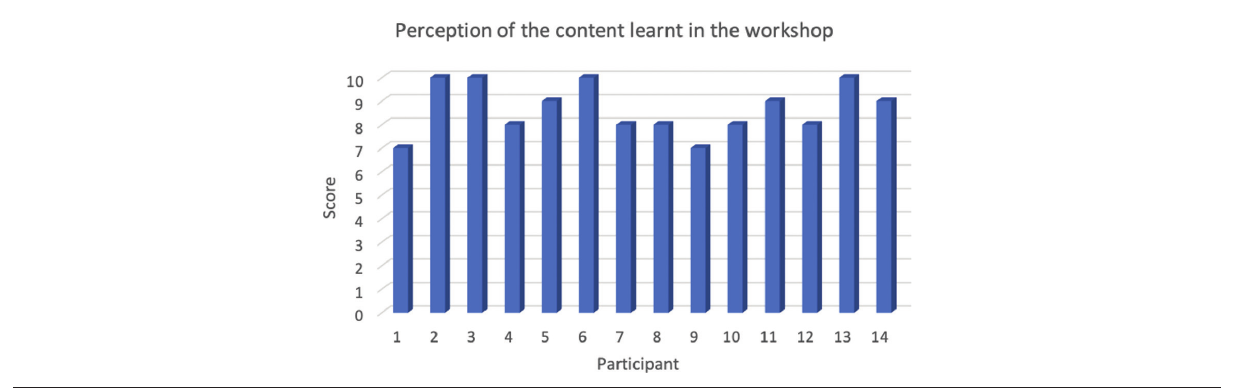
Figure 19. Perception of the content learnt from the workshop (Source: Author,